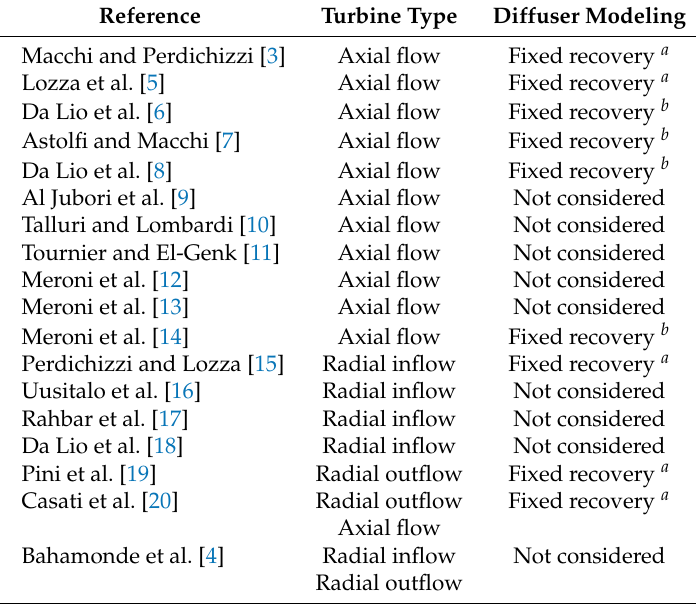
Table 1. Treatment of the diffuser in the literature about turbine preliminary